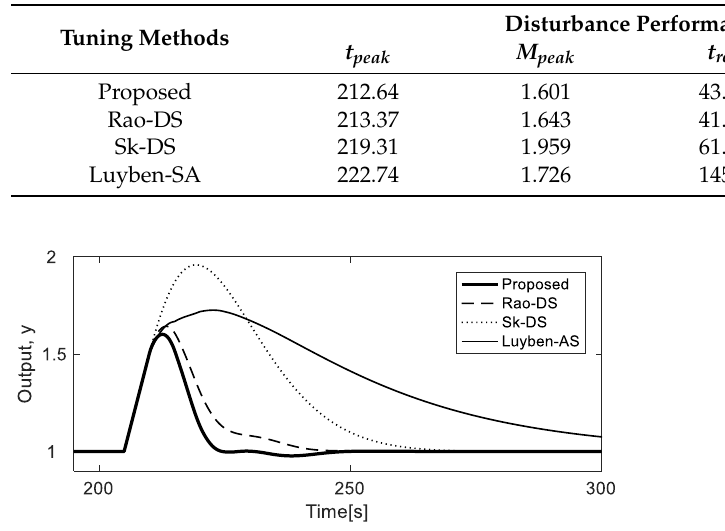
Figure 6. Regulatory responses to disturbance in perfect model of PIPTD. Table 3. Quantitative comparison of responses to disturbance in perfect model of PIPTD.